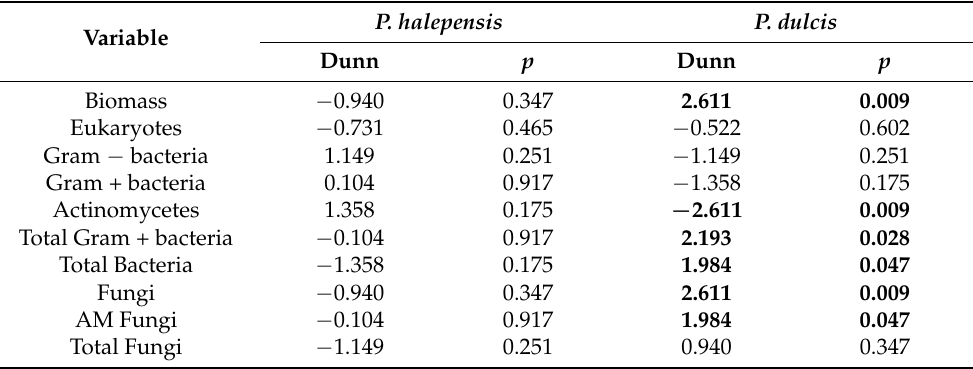
Table 2. Comparison of soil features between control and manure trees of the two study species based on the biomass data of the main microbiota groups. Statistics show the values of Dunn tests and their associated probability level. Significant ( p < 0.05) differences are indicated with values in bold characters. AM Fungi are arbuscular mycorrhizal fungi. P. halepensis P. dulcis Variable